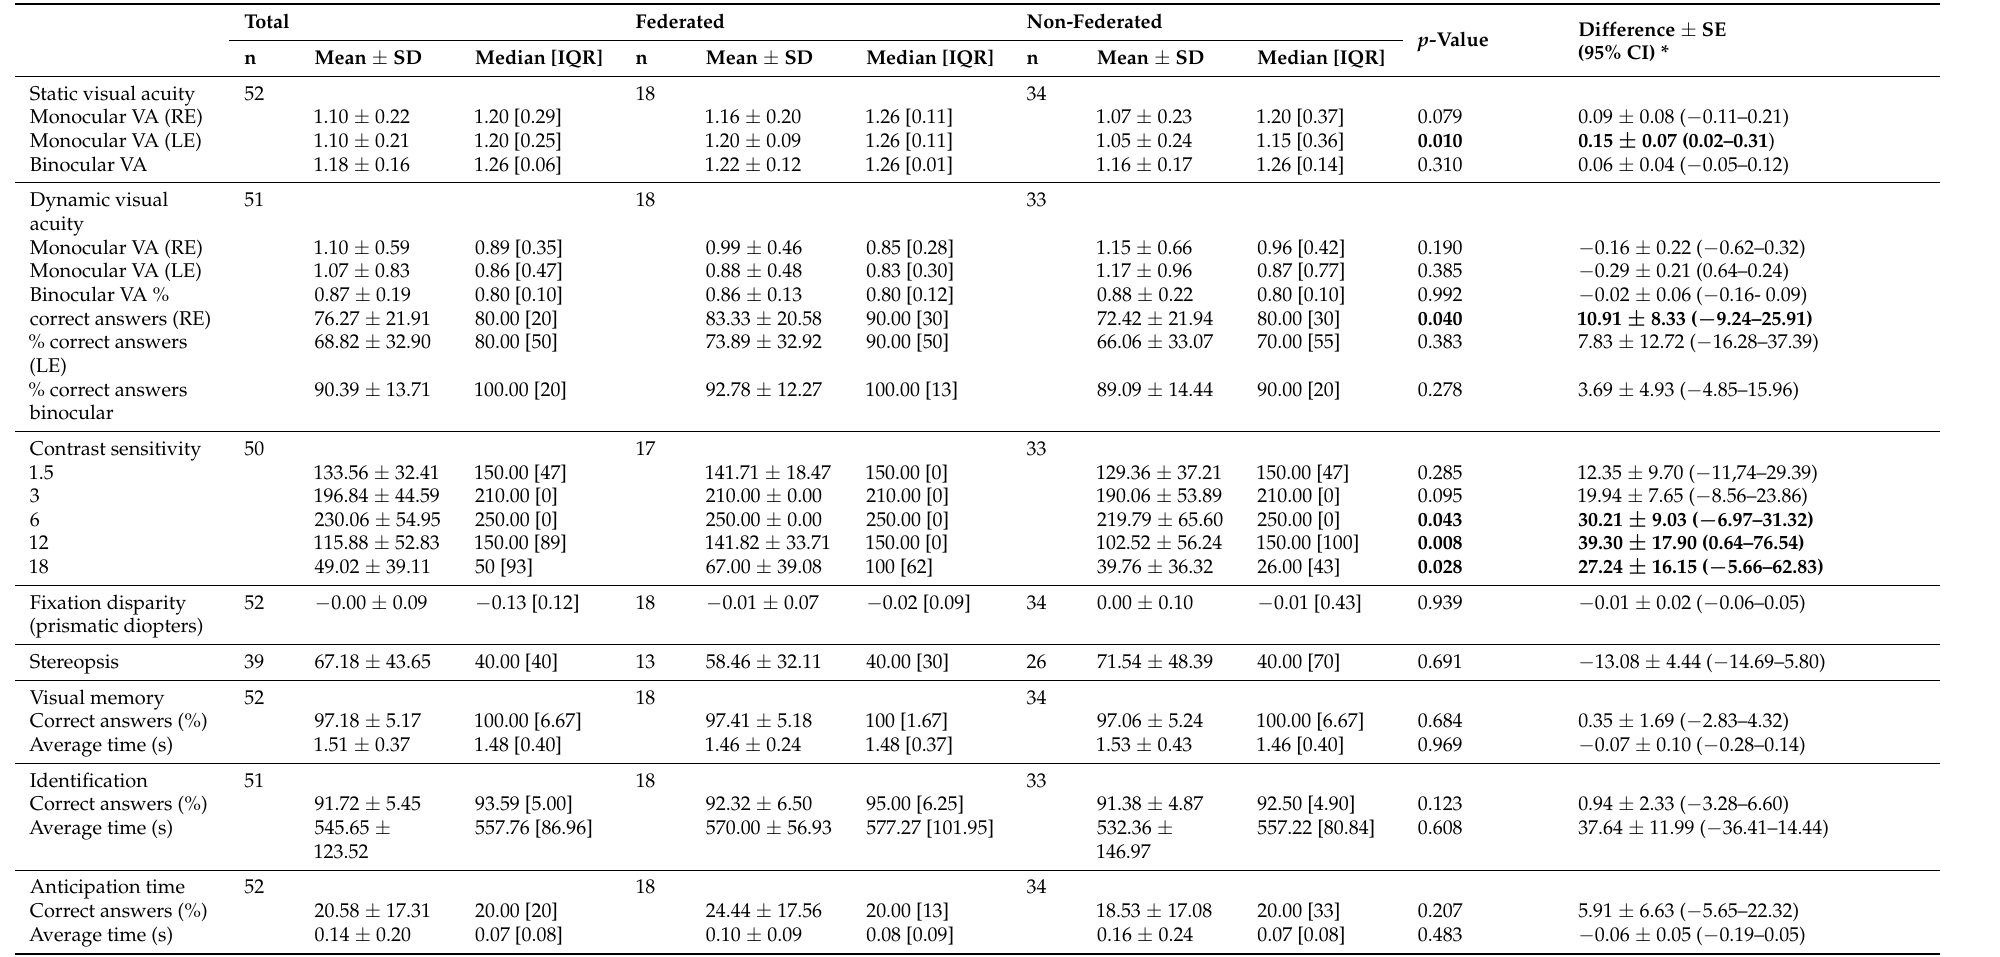
Table 5. Visual assessment